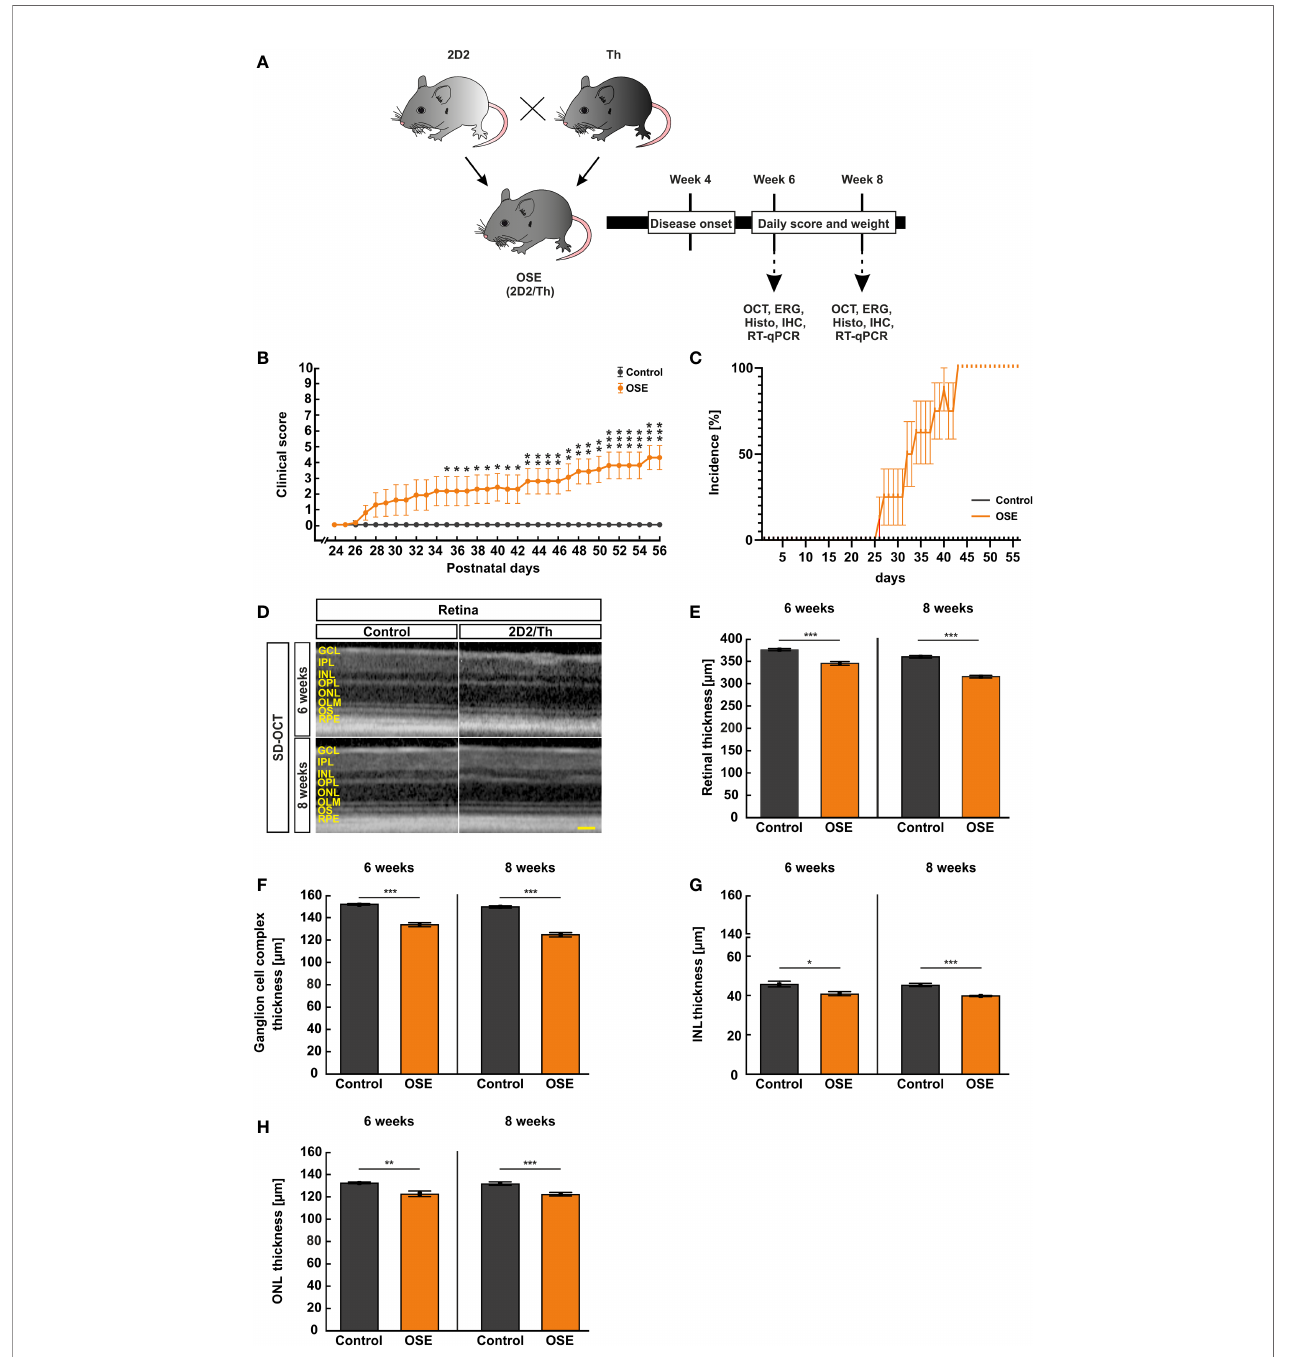
FIGURE 1 | Neurological signs in accordance with structural impairment of the retina. (A) Study design. (B) OSE mice showed clinical signs of encephalomyelitis with fl accid hind limb paralysis starting at day 26. A signi fi cantly higher score was observed in OSE mice while control mice remained healthy. (C) Additionally, 50% of OSE mice were affected after 32 days. The incidence increased to 75% at day 38 in OSE mice. (D) SD-OCT measurements were performed in six- and eight- week-old mice to evaluate the retinal thickness. (E) The morphological analysis of the retina revealed a reduction of the retinal thickness (ganglion cell complex to ONL) in six-week-old OSE animals in comparison to the control group. The reduction of the retinal thickness was also noted after eight weeks. (F) The ganglion cell complex thickness (RNFL, GCL and IPL) was reduced by 6.5% in eight-week-old OSE mice. (G) The INL thickness decreased by 2.5% between six and eight weeks time point in OSE mice. (H) A slight reduction of ONL thickness by 0.4% was seen in OCT analysis in the OSE group. Data are shown as mean ± SEM. ERG, electroretinogram; GCL, ganglion cell layer; Histo, histology; IHC, immunohistochemistry; IPL, inner plexiform layer; INL, inner nuclear layer; OCT, optical coherence tomography; OPL, outer plexiform layer; ONL, outer nuclear layer; OLM, outer limiting membrane; OS, outer segment; RPE, retinal pigment epithelium; RT-qPCR, quantitative real-time polymerase chain reaction. *p < 0.05, **p < 0.01, ***p < 0.001. Scale bar: 200 m